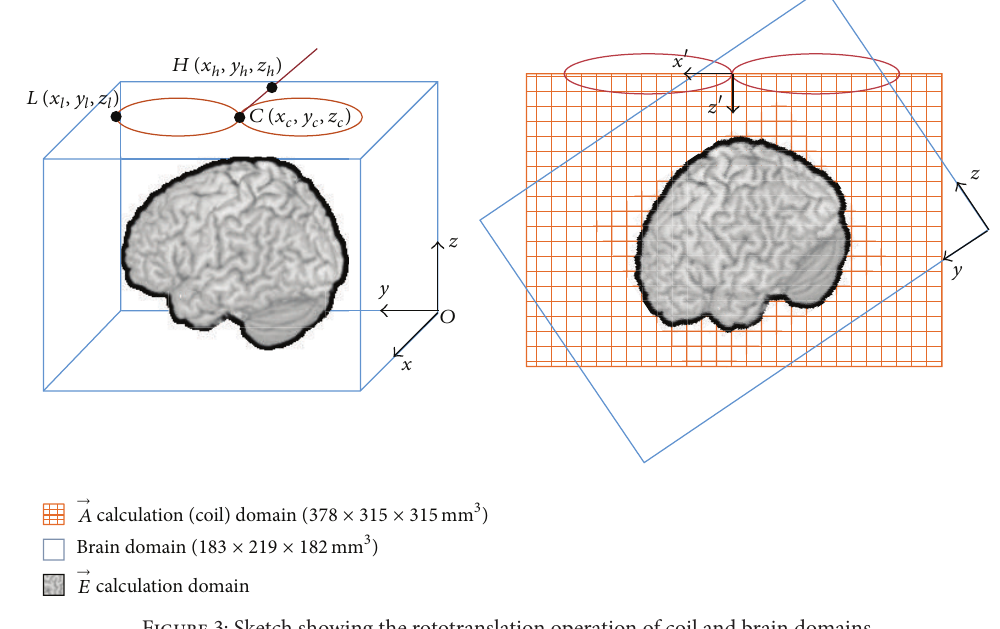
Figure 3: Sketch showing the rototranslation operation of coil and brain